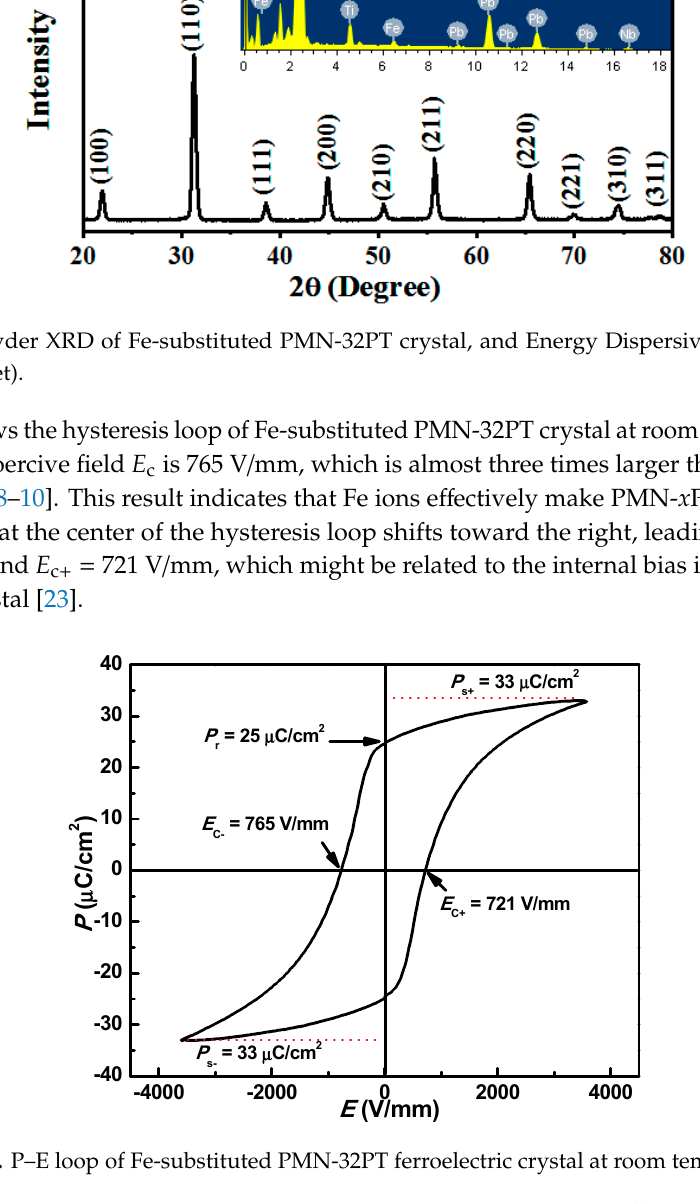
Figure 2. P–E loop of Fe-substituted PMN-32PT ferroelectric crystal at room temperature.